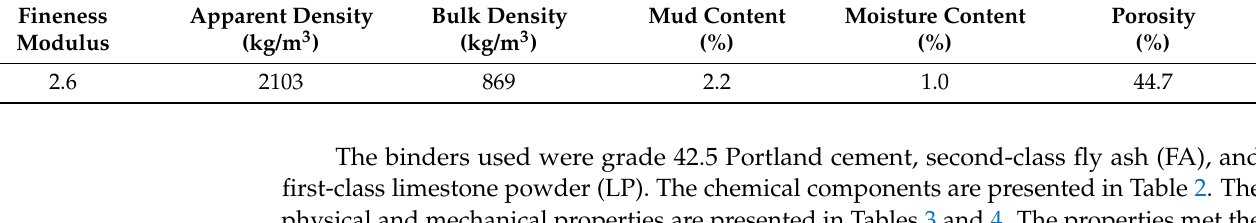
Figure 1. Photos of sintered sludge: ( a ) a prototype of sintered sludge; ( b ) graded fine aggregate. Table 1. Physical properties of the fine, lightweight aggregate sintered sludge.